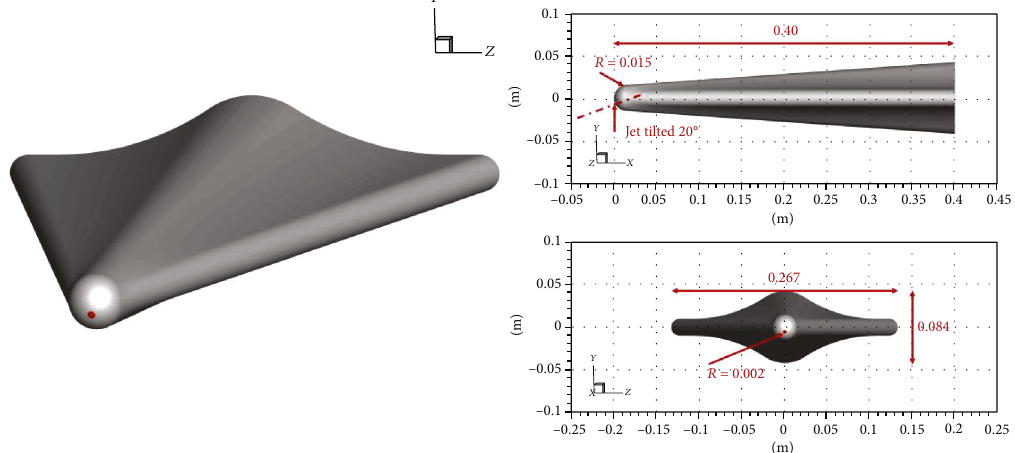
Figure 3: Geometry and dimensions of the model.